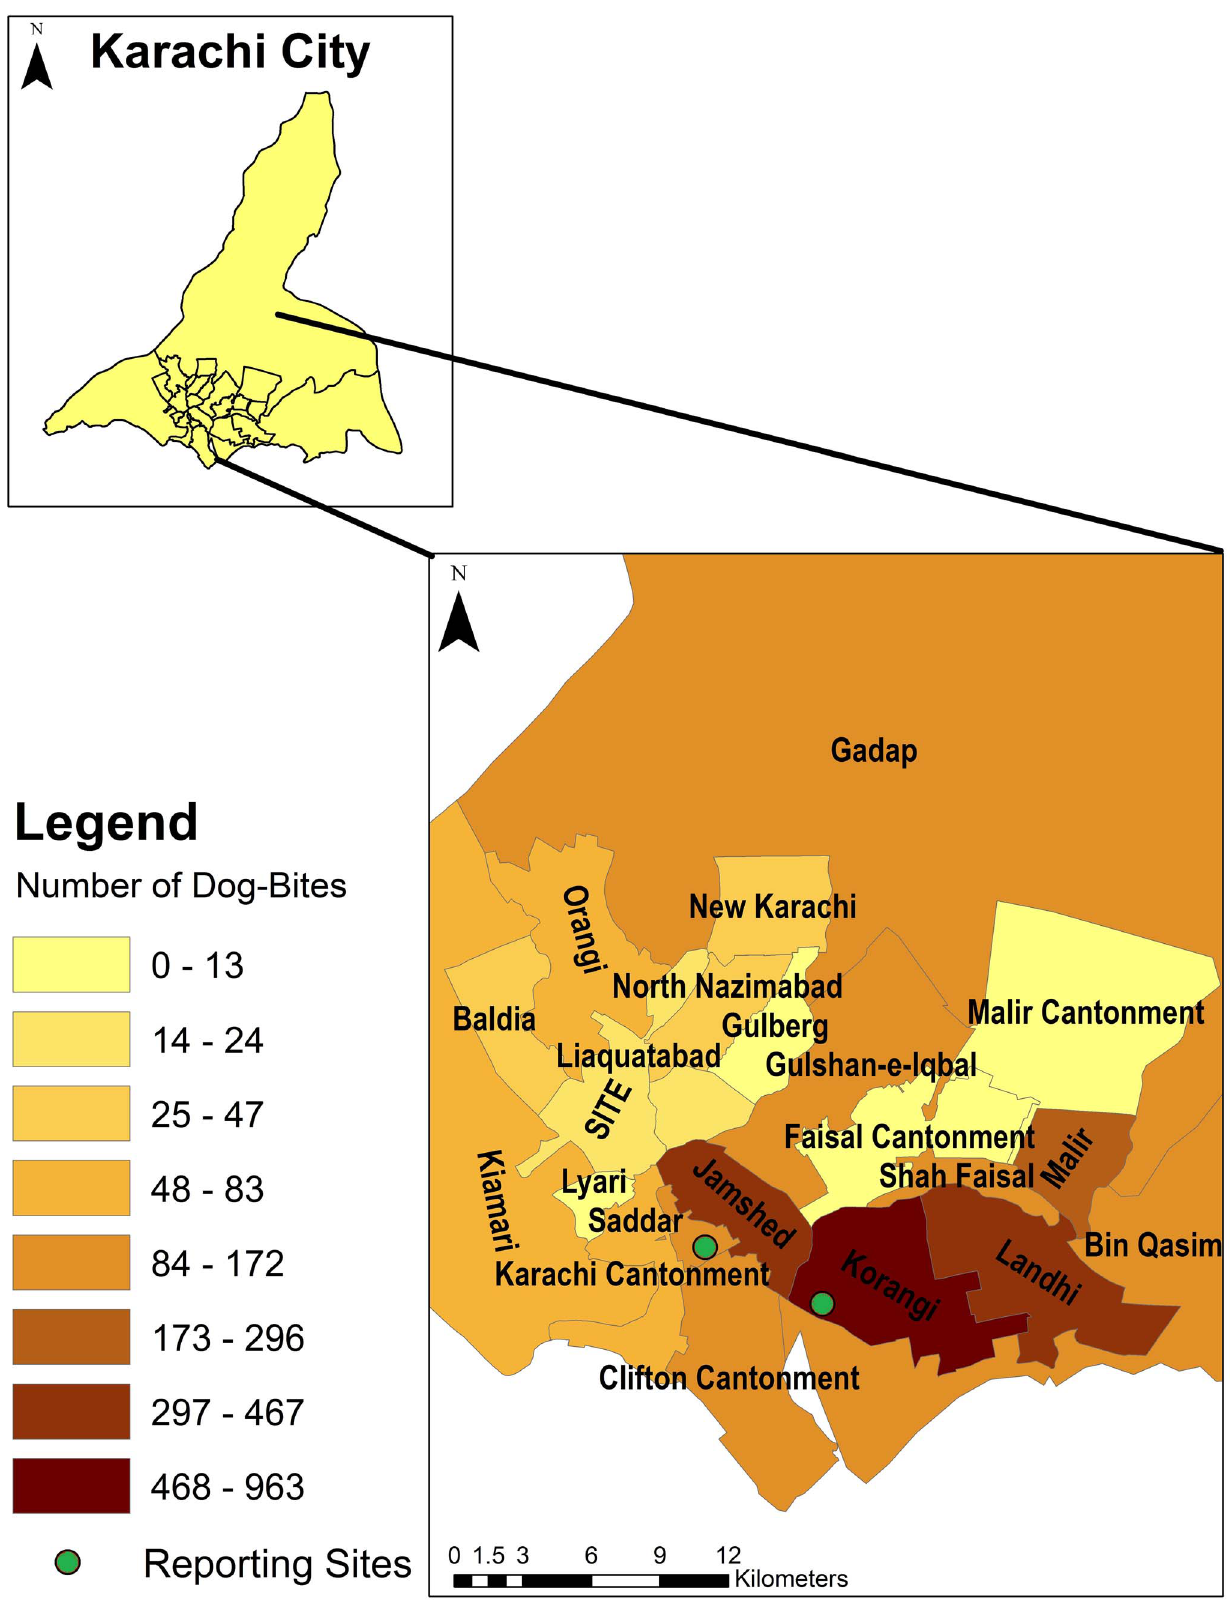
Figure 2. Spatial mapping of dog-bites cases by administrative towns in Karachi, Pakistan between Feb 2009–Feb 2011.